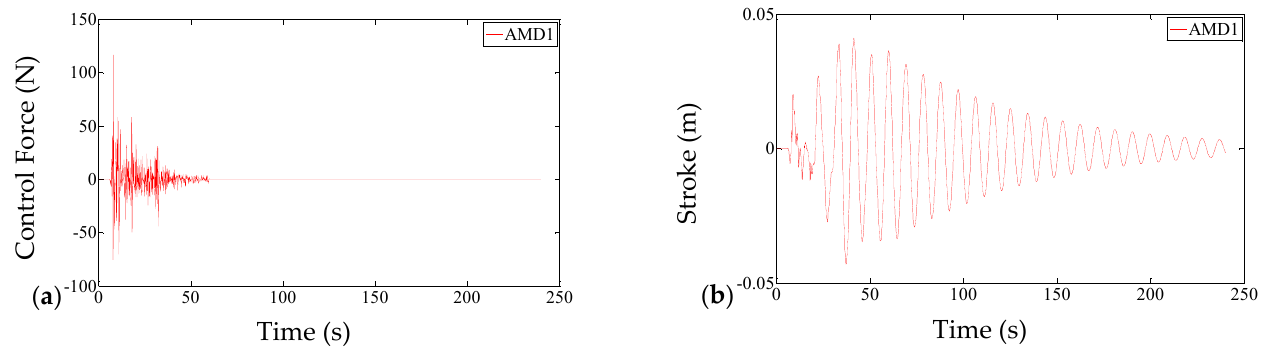
Figure 7. The AMD1 parameters of System2 with unequal time delays, ( a ) the forces and ( b ) the strokes.